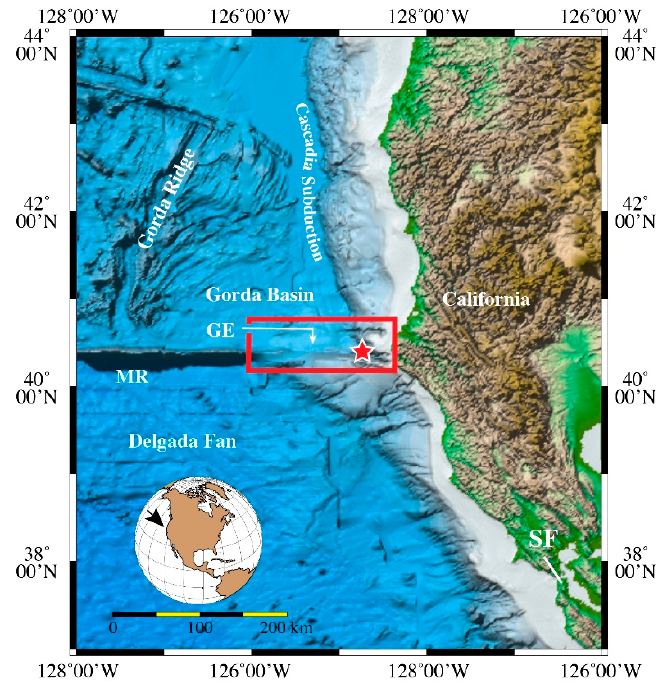
Figure 1. Location of Mendocino Channel (red rectangle) at the base of the northern flank of Gorda Escarpment (GE) in the eastern Pacific Ocean. Red star is Mendocino Triple Junction, MR is Mendocino Ridge and SF is San Francisco, CA. Data from Geomapapp.org v. 3.6.6.